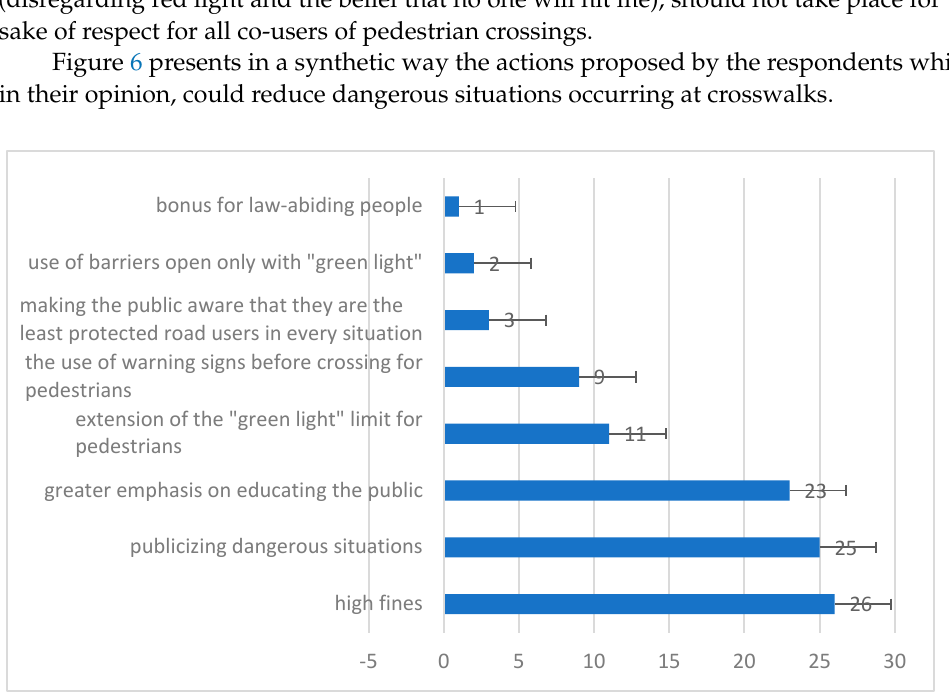
Figure 6. Factors limiting dangerous situations occurring at crosswalks.